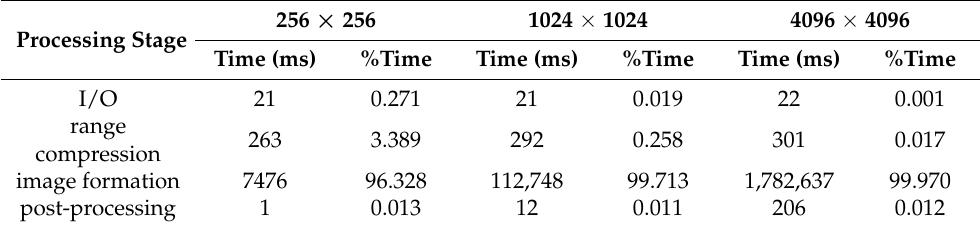
Table 3. The computational complexity of BP-VISAR baseline architecture S1.